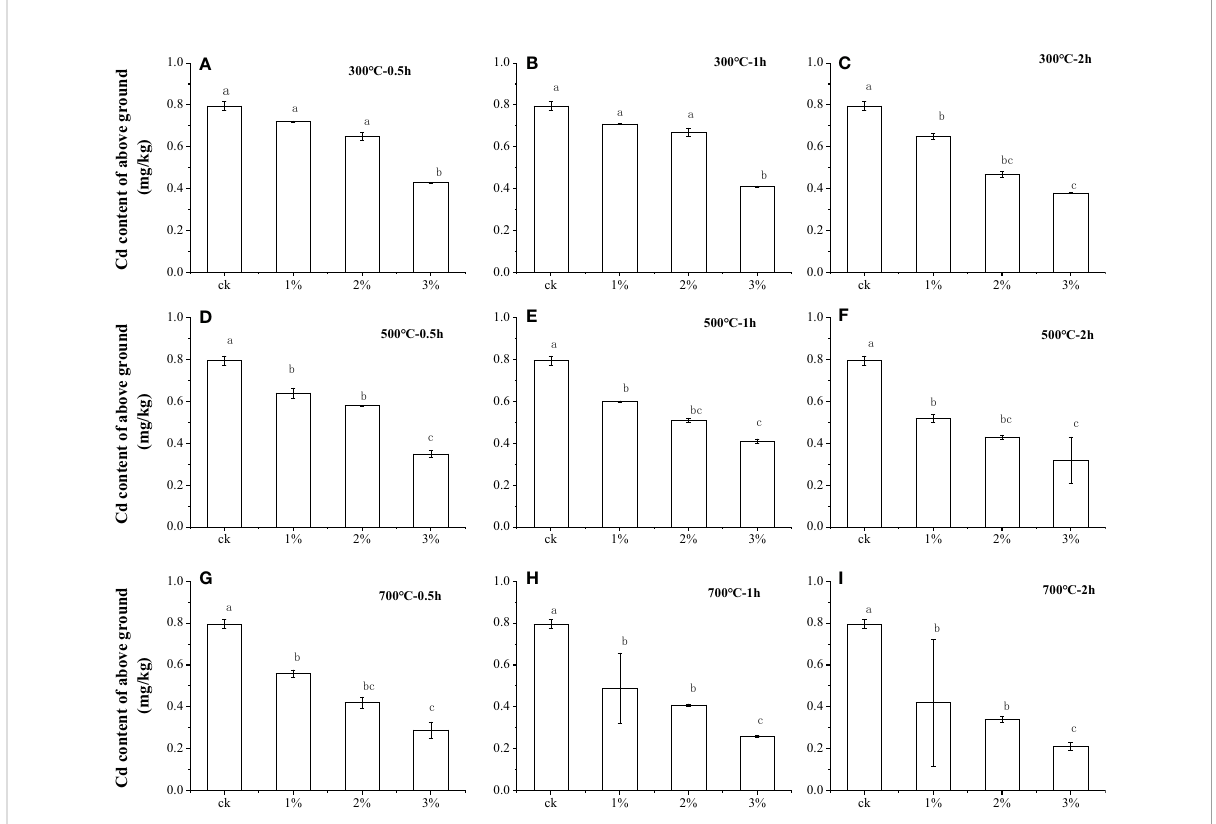
FIGURE 1 Comparison of the Cd content of lettuce shoot after water hyacinth biochar application with different preparation conditions. Small letters indicates signi fi cant